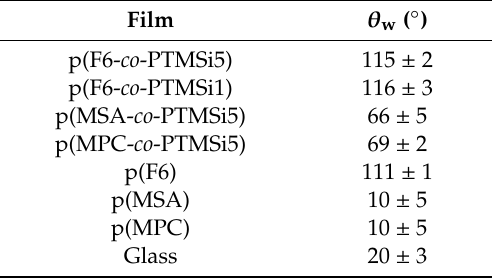
Table 1. Water contact angle for fluorinated and zwitterionic copolymers, the corresponding homopolymers and activated glass.